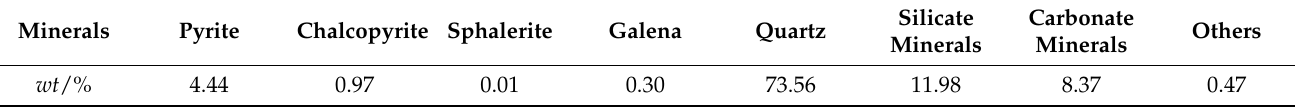
Table 2. Analysis results of mineral composition of cyanide tailings.